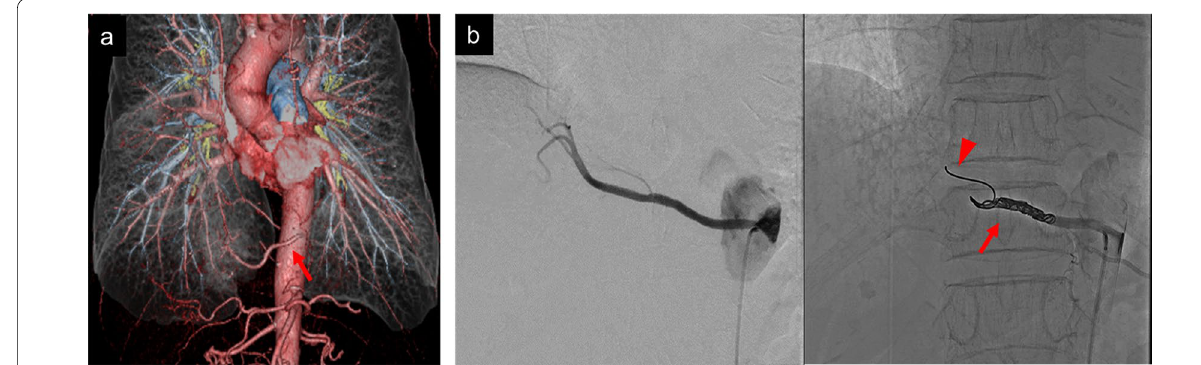
Fig. 1 a Three‑dimensional reconstructed images showing the aberrant artery from the thoracic aorta (red arrow). b Angiography and embolization of the aberrant artery using a coil. The arrow shows coil embolization of the aberrant artery. The arrowhead indicates the coil stump using the first branch of the aberrant artery as an